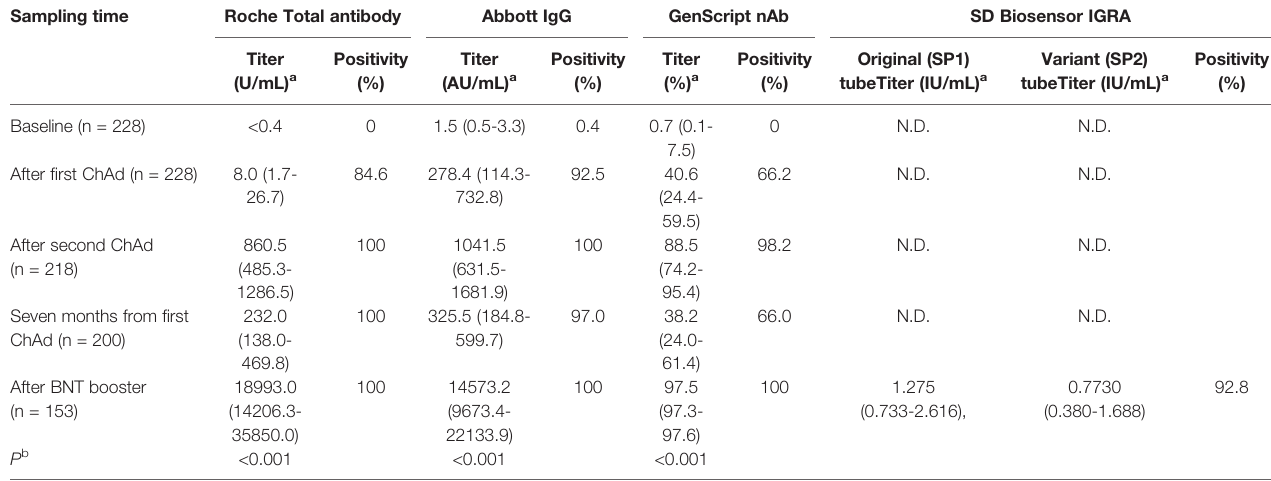
TABLE 2 | Results of the anti-SARS-CoV-2 antibody assays and interferon-gamma releasing assay after two doses of ChAdOx1 nCoV-19 and a booster dose of BNT162b2. Sampling